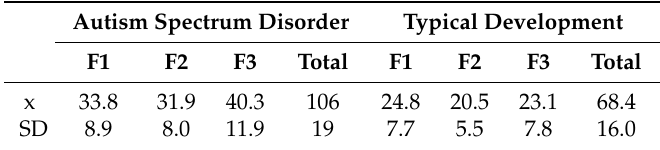
Table 4. Descriptive statistics of ASD and typical development samples.